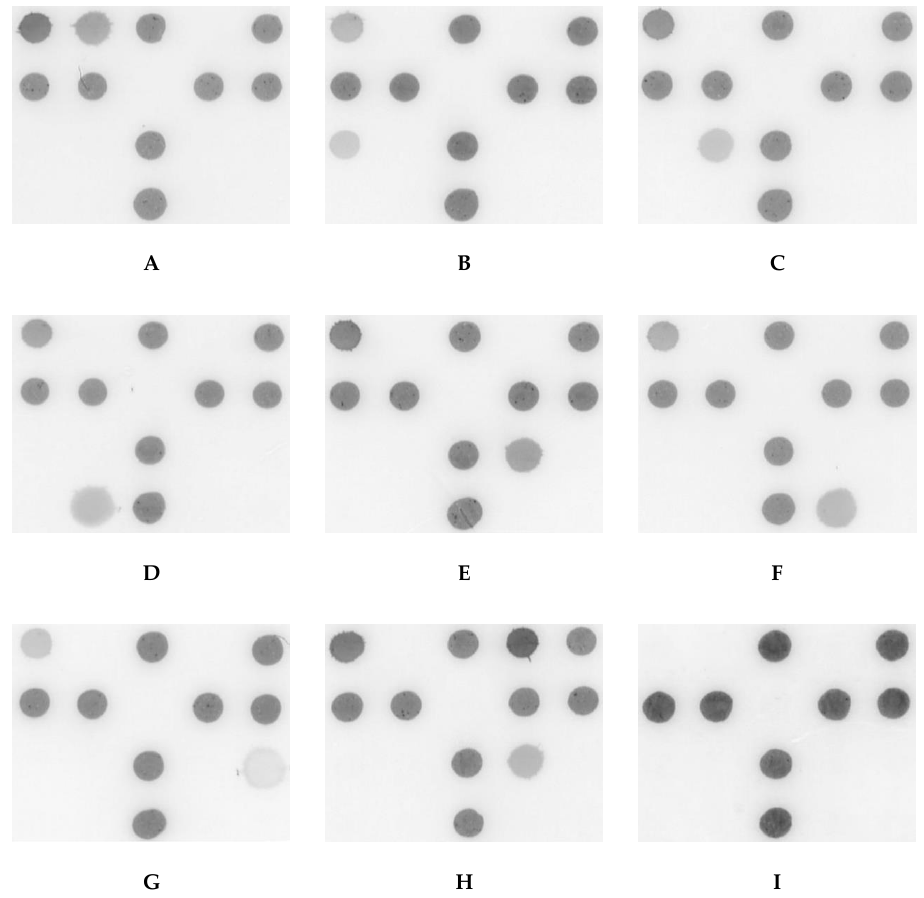
Figure 2. Representative test results of dot hybridization assay for detecting the putative Figure2. Representativetestresultsofdothybridizationassayfordetectingtheputativemicroorganisms of core ocular surface